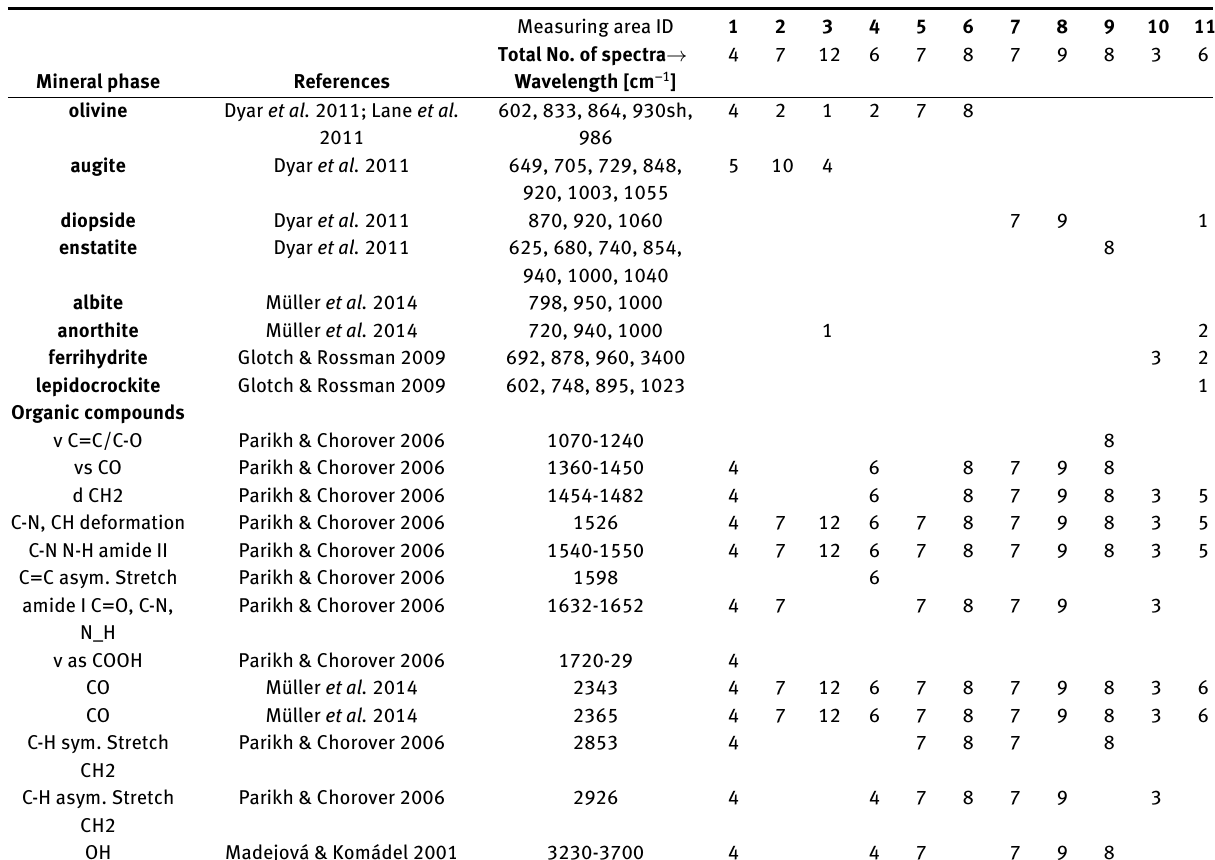
Table 1. Vibration bands of organic material and minerals with references.